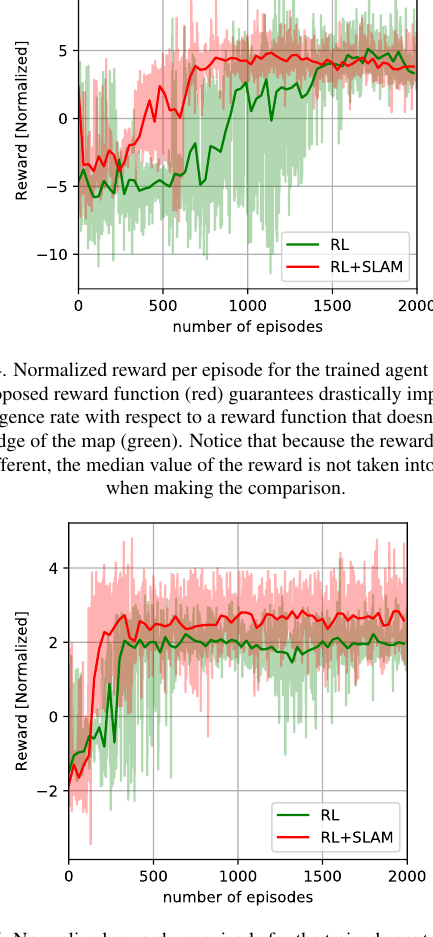
Figure 5. Normalized reward per episode for the trained agent (Target 2). Even when the path doesn’t require go around an obstacle, the proposed reward function (red) outperform a reward function that doesn’t use the knowledge of the map